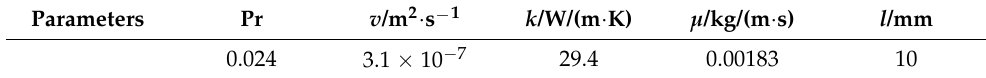
Table 1. Values of the constant.